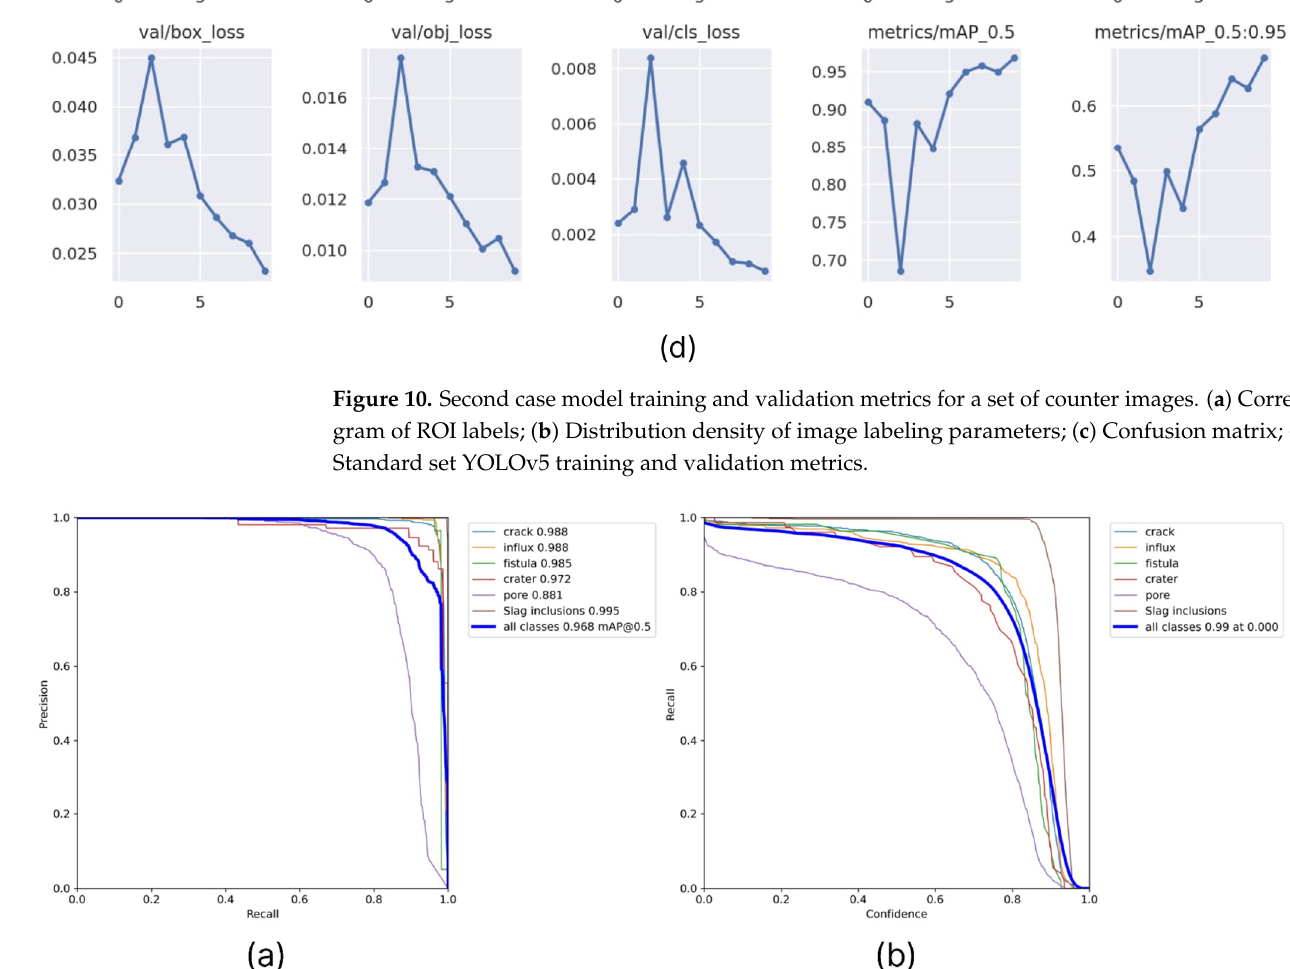
Figure 11. Mutual dependencies of the model metric indicators used in the second case: ( a ) preci- sion–recall, ( b ) recall–confidence, ( c ) precision–confidence, and ( d ) F1–confidence. In addition to these algorithms for the detection and identification of defects in welded joints, an approach based on the analysis of the obtained point clouds of the ob- ject surface under study was used. Strictly speaking, we determined each point potential from the set belonging to a possible defect using the random forest algorithm. In this case, the point clouds belonging to surface defects and described above served as the in- itial data set. This approach concept is as follows: we consider independently each point from the points cloud corresponding to the one-object measurement and present the probability that this point belongs to one of the six defects. Next, we integrate the number of points that belong to the same defect in the areas of the surface under study, having previously clustered them. If the checksum of the number of points per potential defect exceeds the threshold value, the system determines this as a precursor of a weld defect. Since we know in advance the geometry of the control measurements and the survey scale, the values of the threshold values of the control sums were chosen on the basis of the average geometric dimensions of real defects and are unique for each type of defect. Data on the training and testing processes of the random forest algorithm are shown in Figure 12.